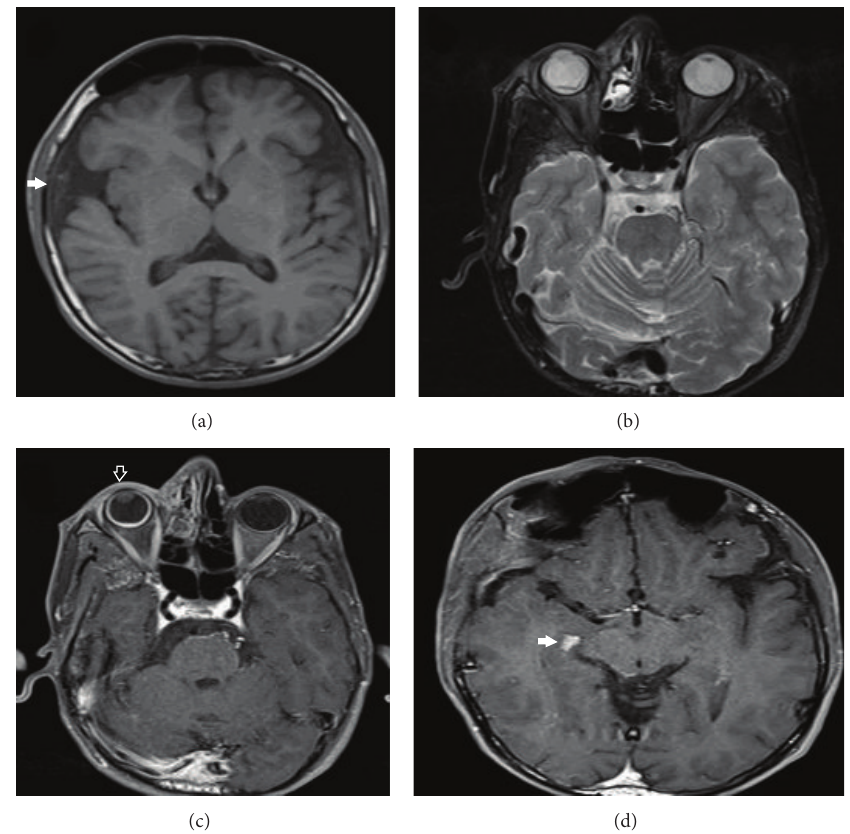
Figure 3: Cranial magnetic resonance imaging studies showed cortical atrophy discordant to his age (a), asymmetric vascular dilatations in the right hemisphere (b), hypertrophy in the right periorbital soft tissue (c), and choroidal plexus (d).